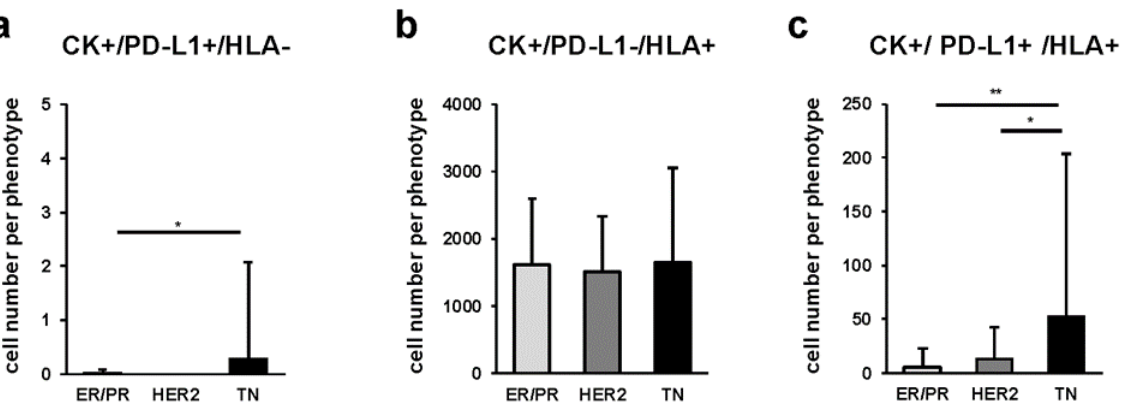
Figure 5. Comparison of multiple-marker-stained cancer cells among ER/PR, HER2, and TN subtypes. Average number of cells stained for multiple markers: ( a ) CK+/PD-L1+/HLA- (* indicates p = 0.026), ( b ) CK+/PD-L1-/HLA+, and ( c ) CK+/PD-L1+/HLA+ (* and ** indicate p = 0.002 and p < 0.001, respectively) per 1 mm 2 at 5 locations in each subtype; p -value was calculated using one-way ANOVA test and Tukey’s multiple comparison test. Error bars represent standard deviation.